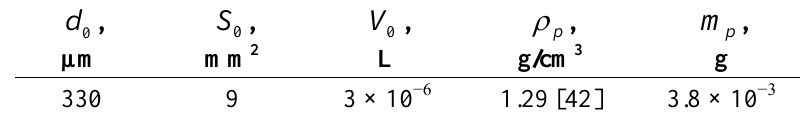
Table 1. Parameters of the investigated AAm/3-AAmPBA/BIS layer.